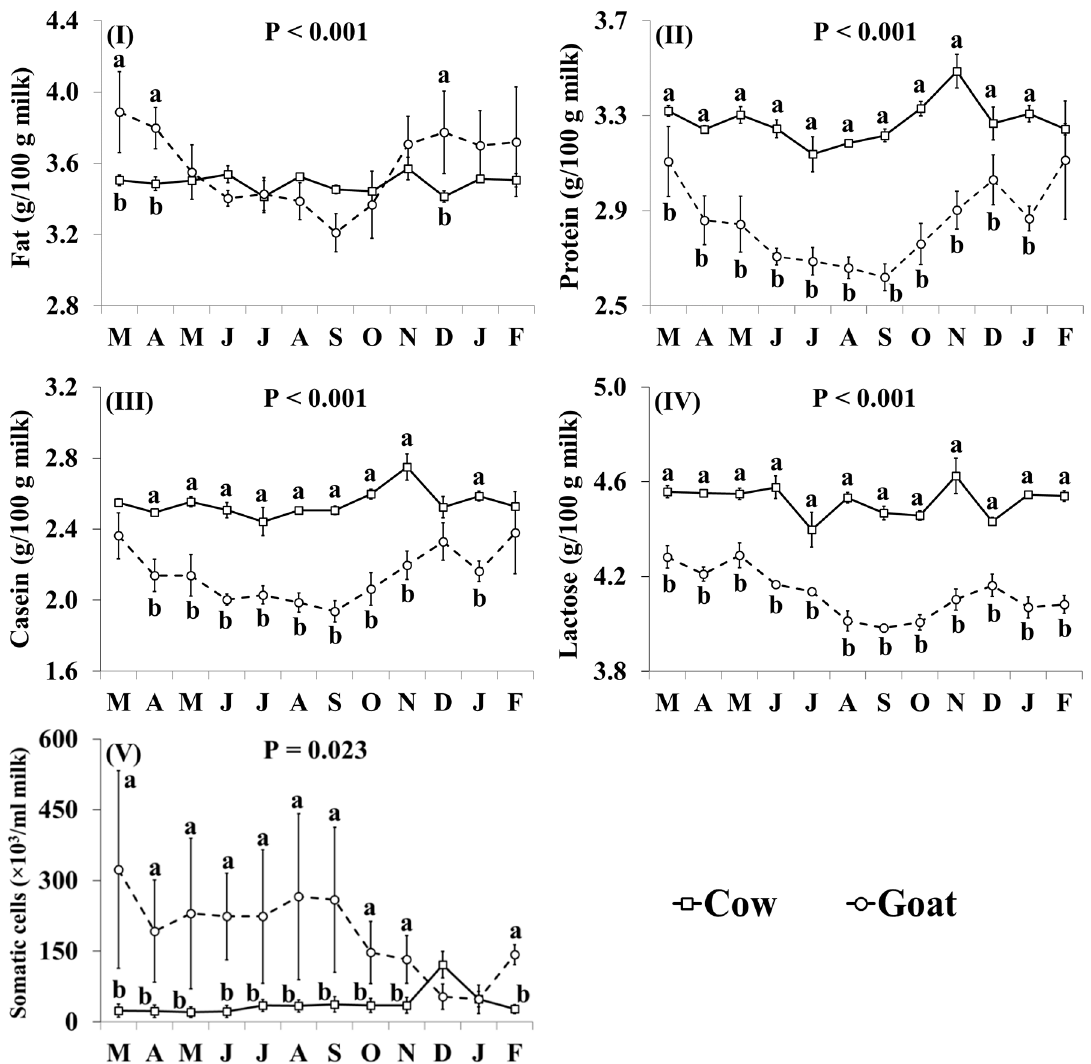
Figure 1. Interaction means ± SE (error bars) for the effects of species (cow, goat) and month (in order of appearance from left to right in Axis X: M, March; A, April; M, May; J, June; J, July; A, August; S, September; O, October; N, November; D, December; J, January; F, February) on the basic composition of retail milk: ( I ) fat content; ( II ) protein content; ( III ) casein content; ( IV ) lactose content; ( V ) somatic cell count. P represents the ANOVA p -value for the interaction. Means for species and within a month with different lowercase letters are significantly different according to Fisher's Least Significant Difference test ( p < 0.05).